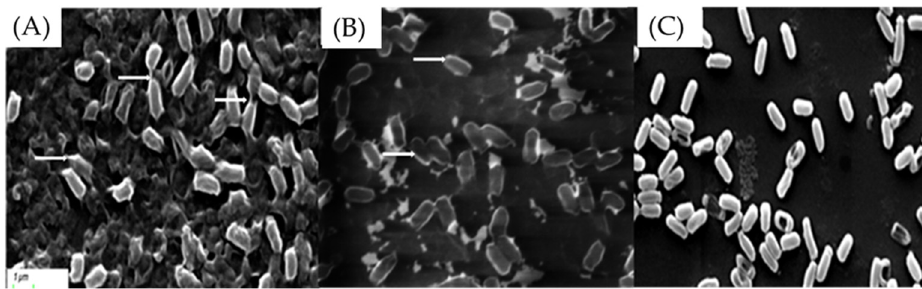
Figure 1. Scanning electron micrographs (bar: 1 μ m) of spores from ( A ) B. horneckiae SBP3, ( B ) B. horneckiae DSM 23495 T and ( C ) B. subtilis 168. Arrows indicate the exosporium layer.